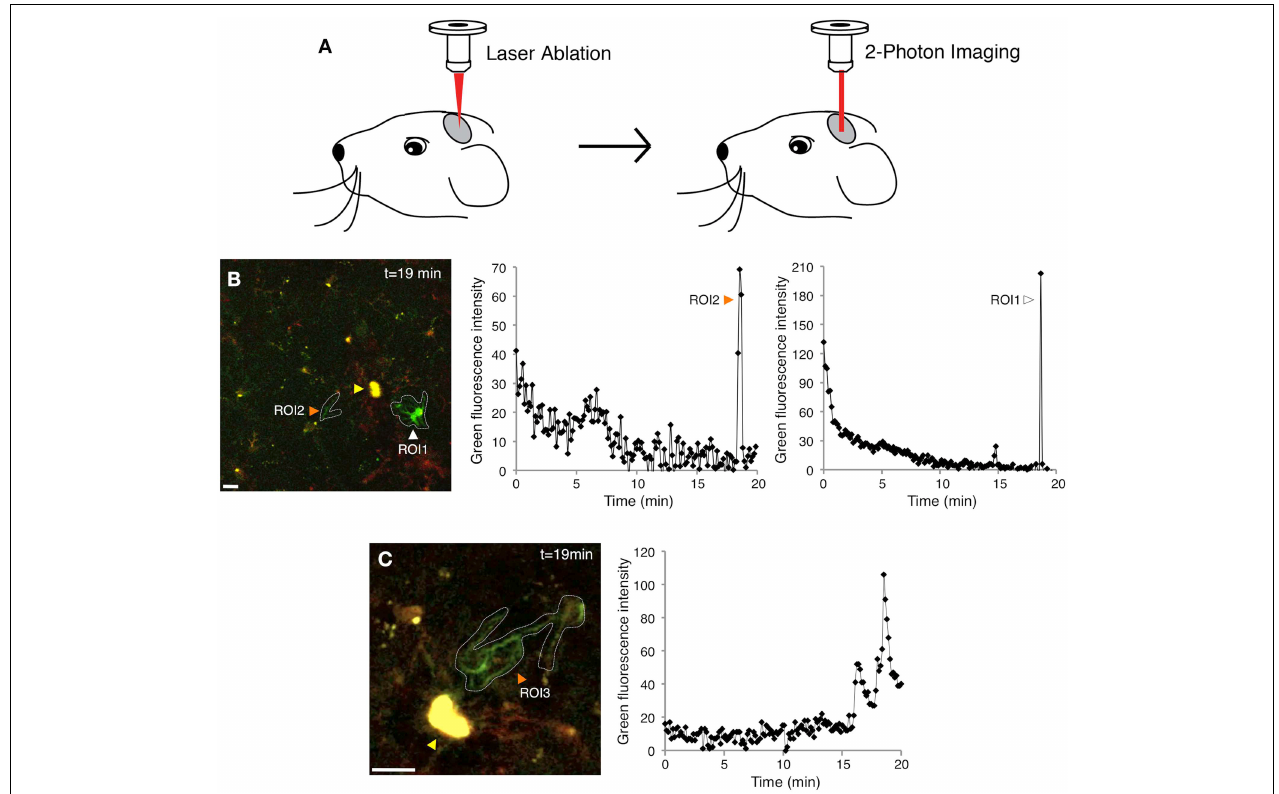
FIGURE 2 | Simultaneous two-photon imaging of tdTomato and GCaMP5G signals in cortical microglia. (A) Cartoon demonstrating the two-photon microscopy approach used to image microglial Ca 2 + responses after laser inflicted focal injury in layer 2/3 of the somatosensory or visual cortex. (B) GCaMP5G fluorescence remains stable, allowing long imaging sessions (Supplementary Movie 2). A recording of green fluorescence intensity in ROI1 (white arrowhead) shows a large Ca 2 + transient in the soma and processes 19 min after